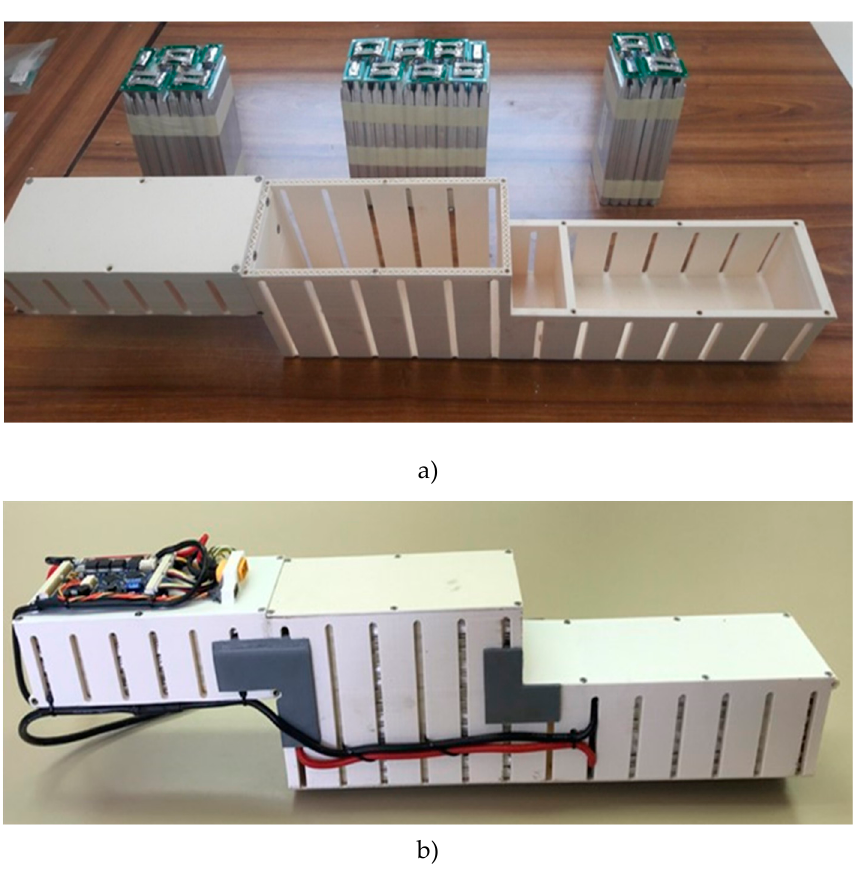
Figure 7 : ( a ) 3D printed batteries case with 3 blocks duly welded together ( b ) batteries connected inside the